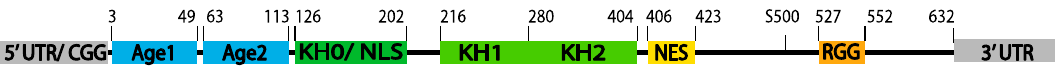
Figure 1. Domain Map of the Fragile X Mental Retardation Protein (FMRP). The domain map of FMRP, displaying its three RNA binding domains: KH1 and KH2 (light green), and arginine-glycine-glycine (RGG) box (orange), two Agenet domains (blue), a newly discovered KH0 domain (dark green) containing the Nuclear Localization Sequence (NLS), the Nuclear Export sequence (NES) (yellow), the 3 ′ UTR (gray) and 5 ′ UTR containing the CGG trinucleotide repeat (gray). Also depicted is Serine 500 (S500) (mus499), the critical site of phosphorylation.